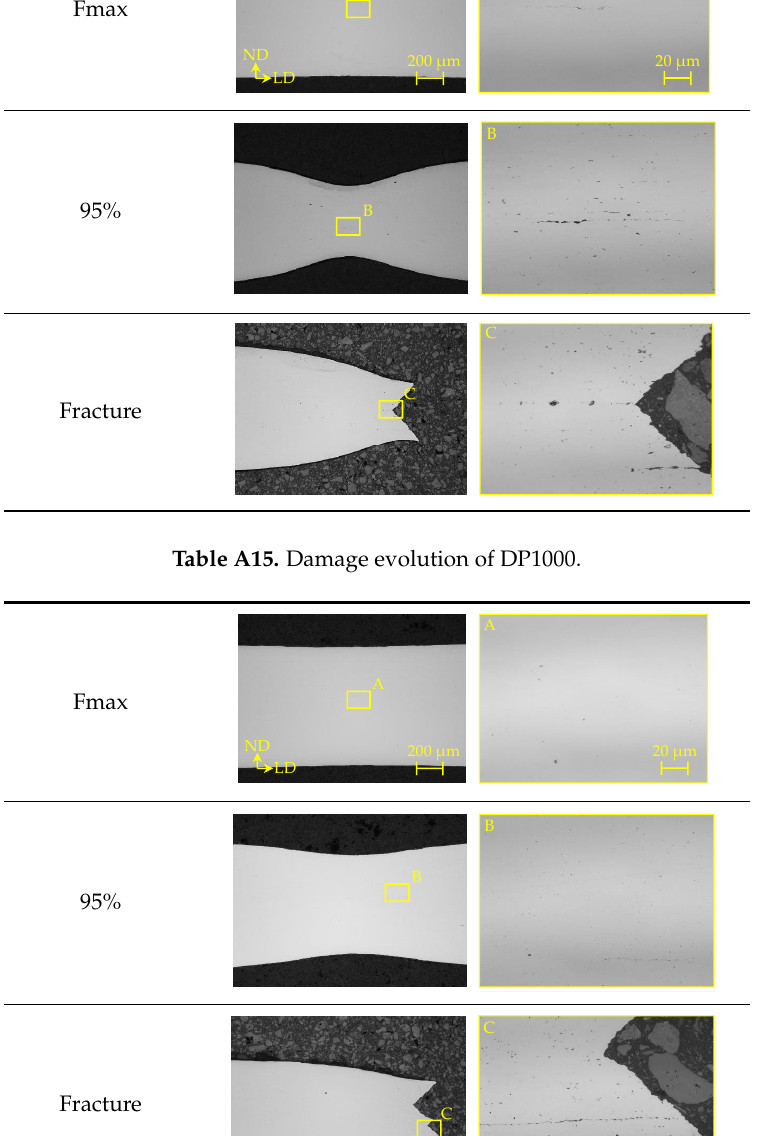
Table A14. Damage evolution of CP800.